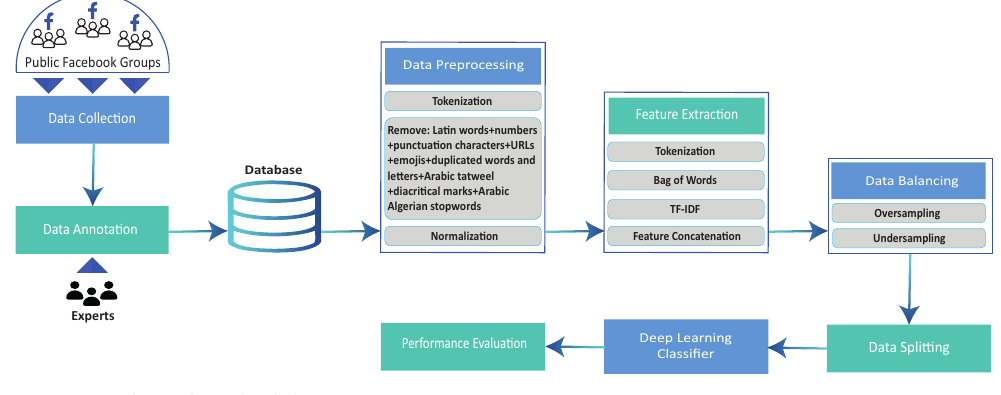
Figure 1. Adopted Methodology.